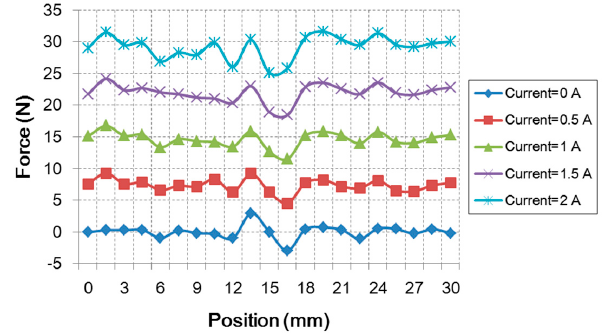
Figure 8. Force outputs of the mover under different phase currents.